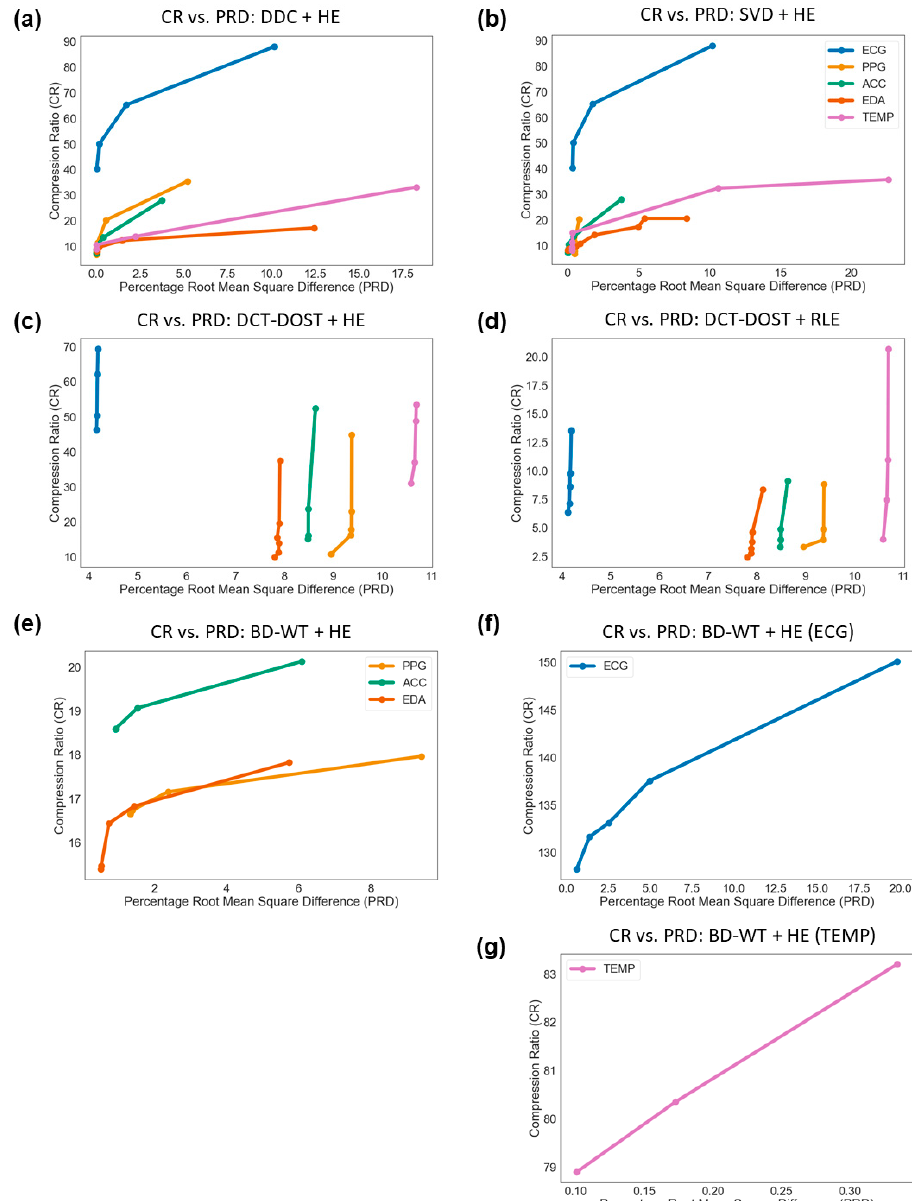
Figure 3. Compression ratio vs. PRD for each data compression pipeline evaluated: ( a ) Direct data compression (DDC) + Huffman encoding (HE), ( b ) singular value decomposition ( SVD ) + HE , ( c ) discrete cosine transform (DCT)-based discrete orthogonal Stockwell transform ( DCT-DOST ) + HE , ( d ) DCT-DOST + run-length encoding ( RLE ), ( e – g ) biorthogonal discrete wavelet transformation ( BD-WT) + HE . The BD-WT + HE pipeline plot is broken down by sensor type due to the large-scale differences of the TEMP ( g ) and ECG ( f ) compression ratios.